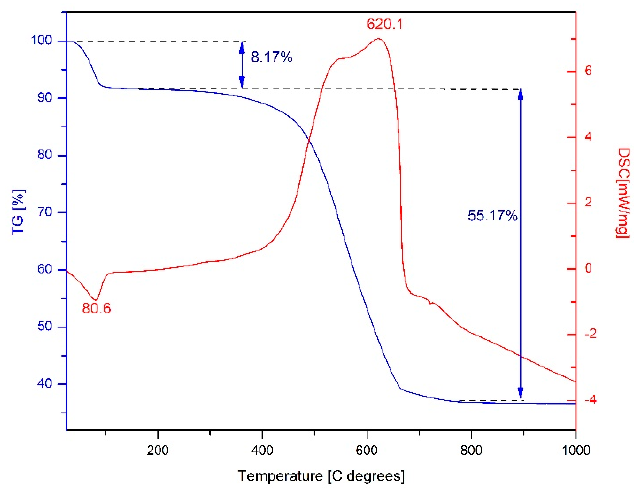
Figure 2. Magnetic hysteresis curve of the Fe 3 O 4 @C matrix.